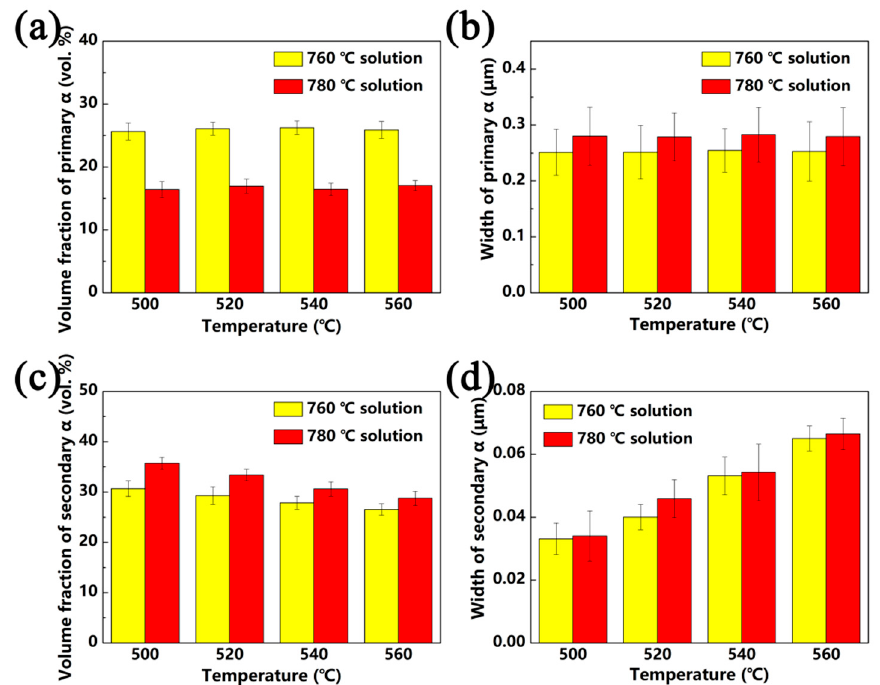
Figure 6. Microstructure features of the α phase that was solution-treated at the α + β region for 1 h and aged for 8 h: ( a ) volume fraction of primary α ; ( b ) width of primary α ; ( c ) volume fraction of secondary α ; ( d ) width of secondary α .